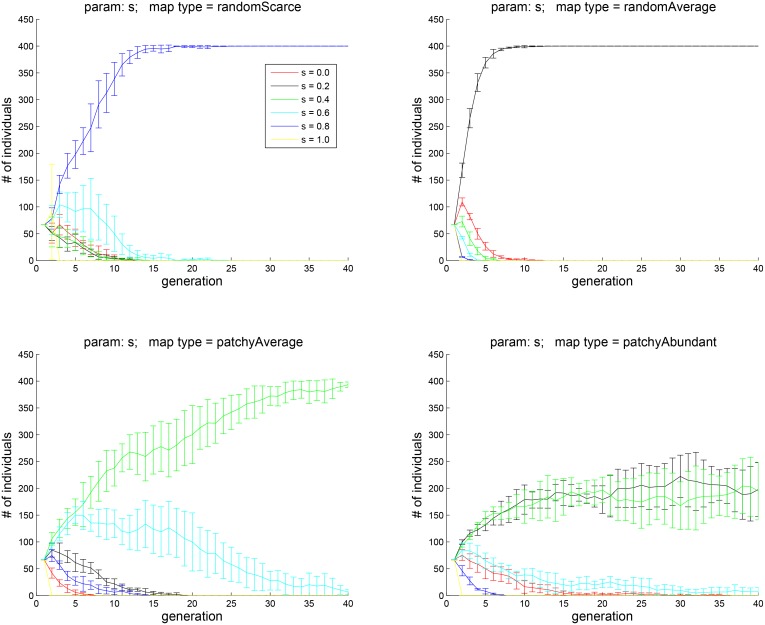
Experiment 3A: the effect of an agent’s social preference.The four subplots correspond to the four environment types shown in Fig 2. Social competitiveness (allowing one’s social group H to drag down one’s own happiness) is shown to play an important role. When food is abundant, agents weight more on foraging is more successful. When food is scarce, agents weight more on socialization emerge as more successful.